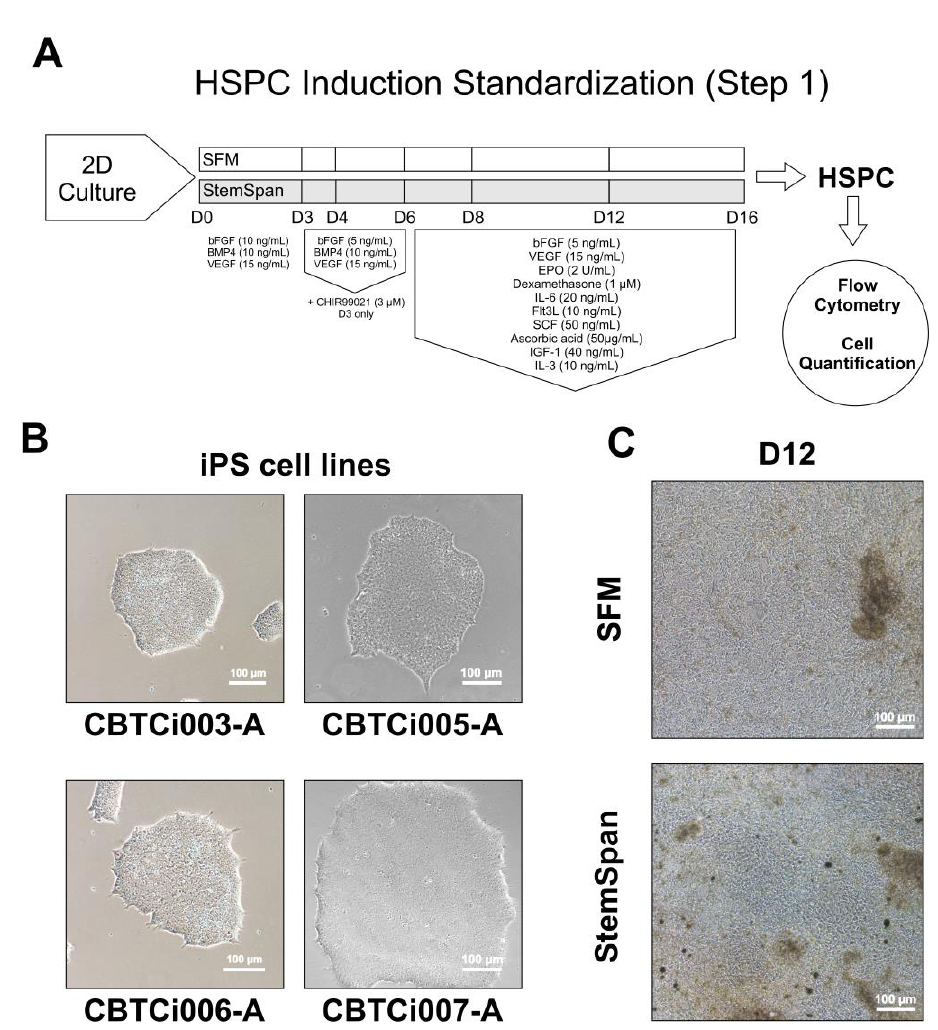
Figure 1. Workflow of the Hematopoietic Stem Progenitor Cell (HSPC) induction methods (Step 1), us- ing different 2D and 3D culture methods, basal media, and supplements ( A ). Representative images of Induced Pluripotent Stem Cell (iPSC) lines CBTCi003-A, CBTCi005-A, CBTCi006-A, and CBTCi007-A at D0 ( B ). Representative images of 2D culture induction at D12 using SFM and StemSpan media with factors ( C ). SFM: Serum-Free